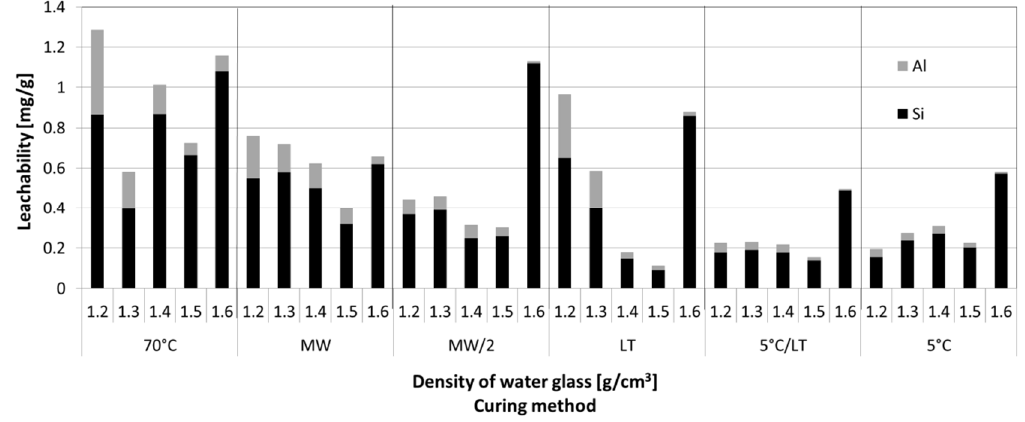
Figure 4. Influence of treatment type and density of water glass on the leachability of Al and Si.